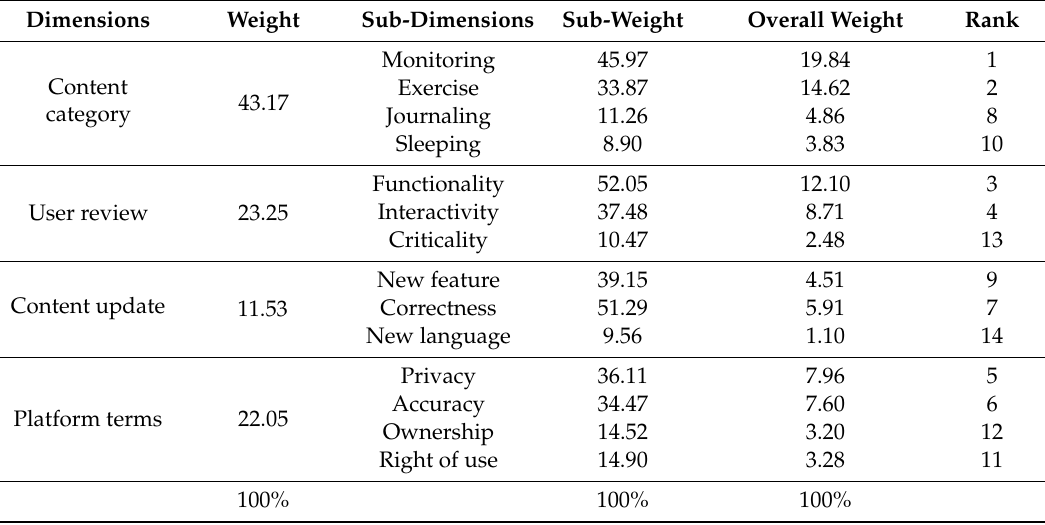
Table 3. Overall Assessments of Panel